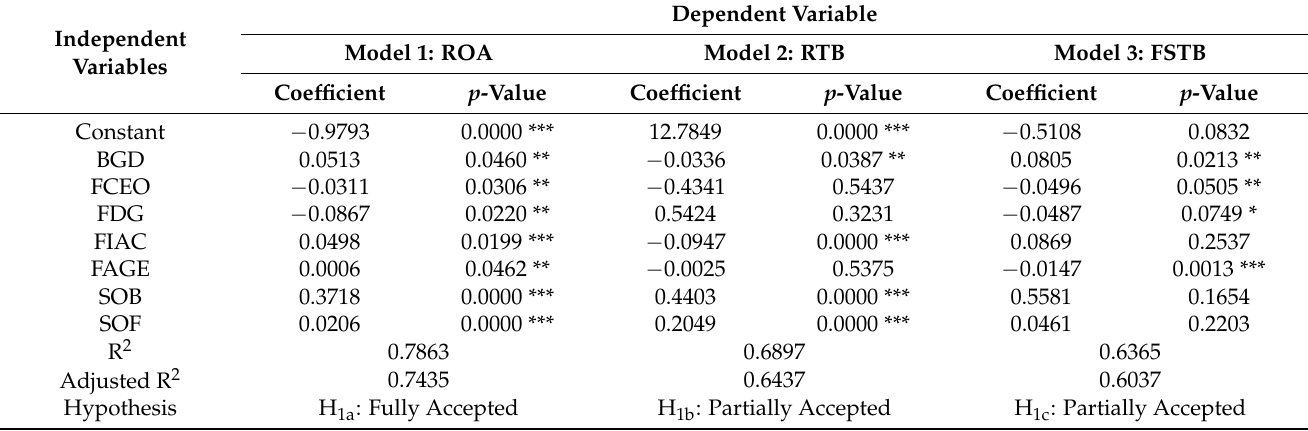
Table 5. Regression